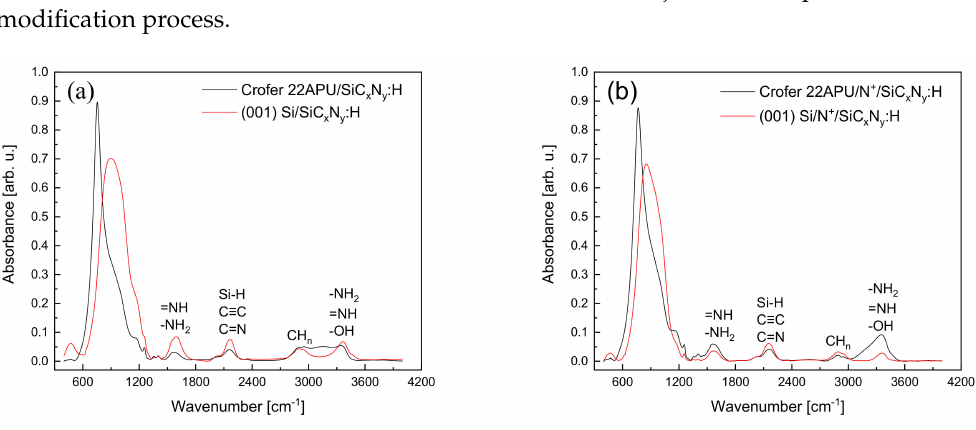
Figure 3. FTIR spectra of modified (001) Si and Crofer 22APU surfaces: ( a ) SiC x N y :H layer, ( b ) N + ion modification, and SiC x N y :H